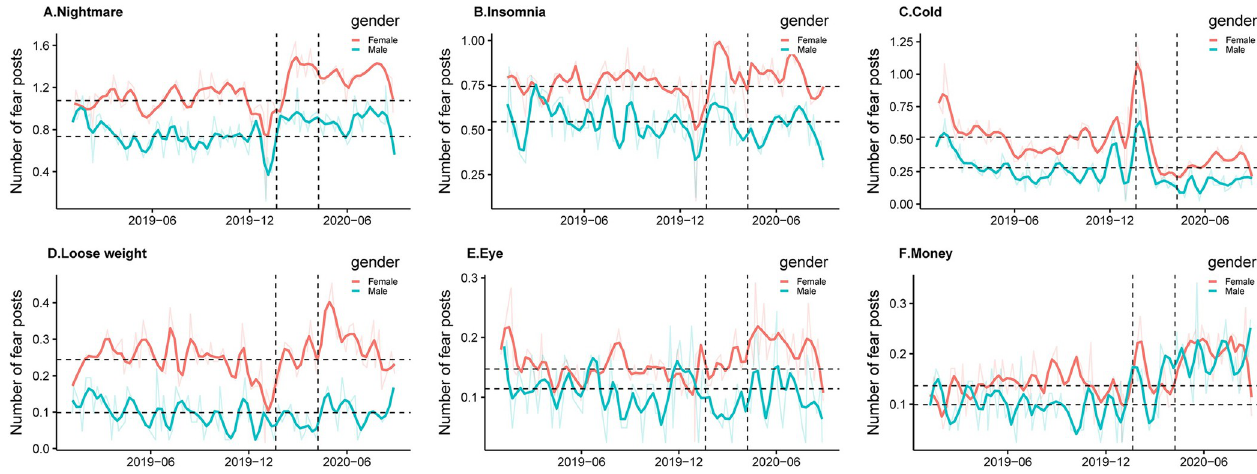
Fig 5. Number of fear posts by topic by gender. Line graphs show the weekly average number of fear posts generated by every 1,000 users in each gender (Female: Solid line above, Male: Solid line below). Two horizontal dashed lines depict the baselines (the mean values of 2019) by gender. Two vertical dashed lines show the start date of COVID-19 (January 20 th ) and the re-open date of Wuhan (April 8 th ).